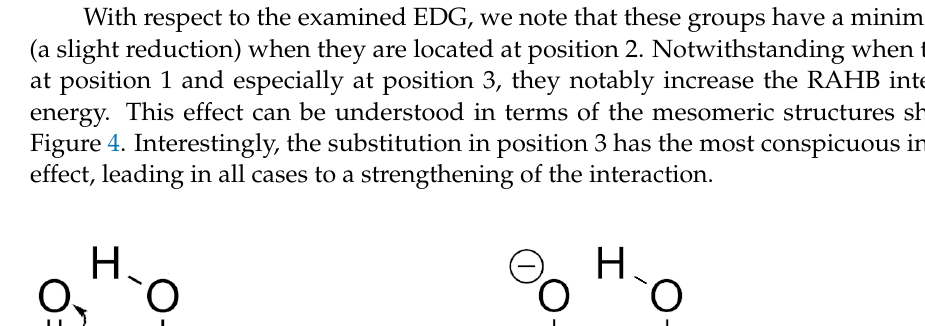
Figure 3. Resonance effect of an electron withdrawing substituent at position 2 in the examined RAHBs.